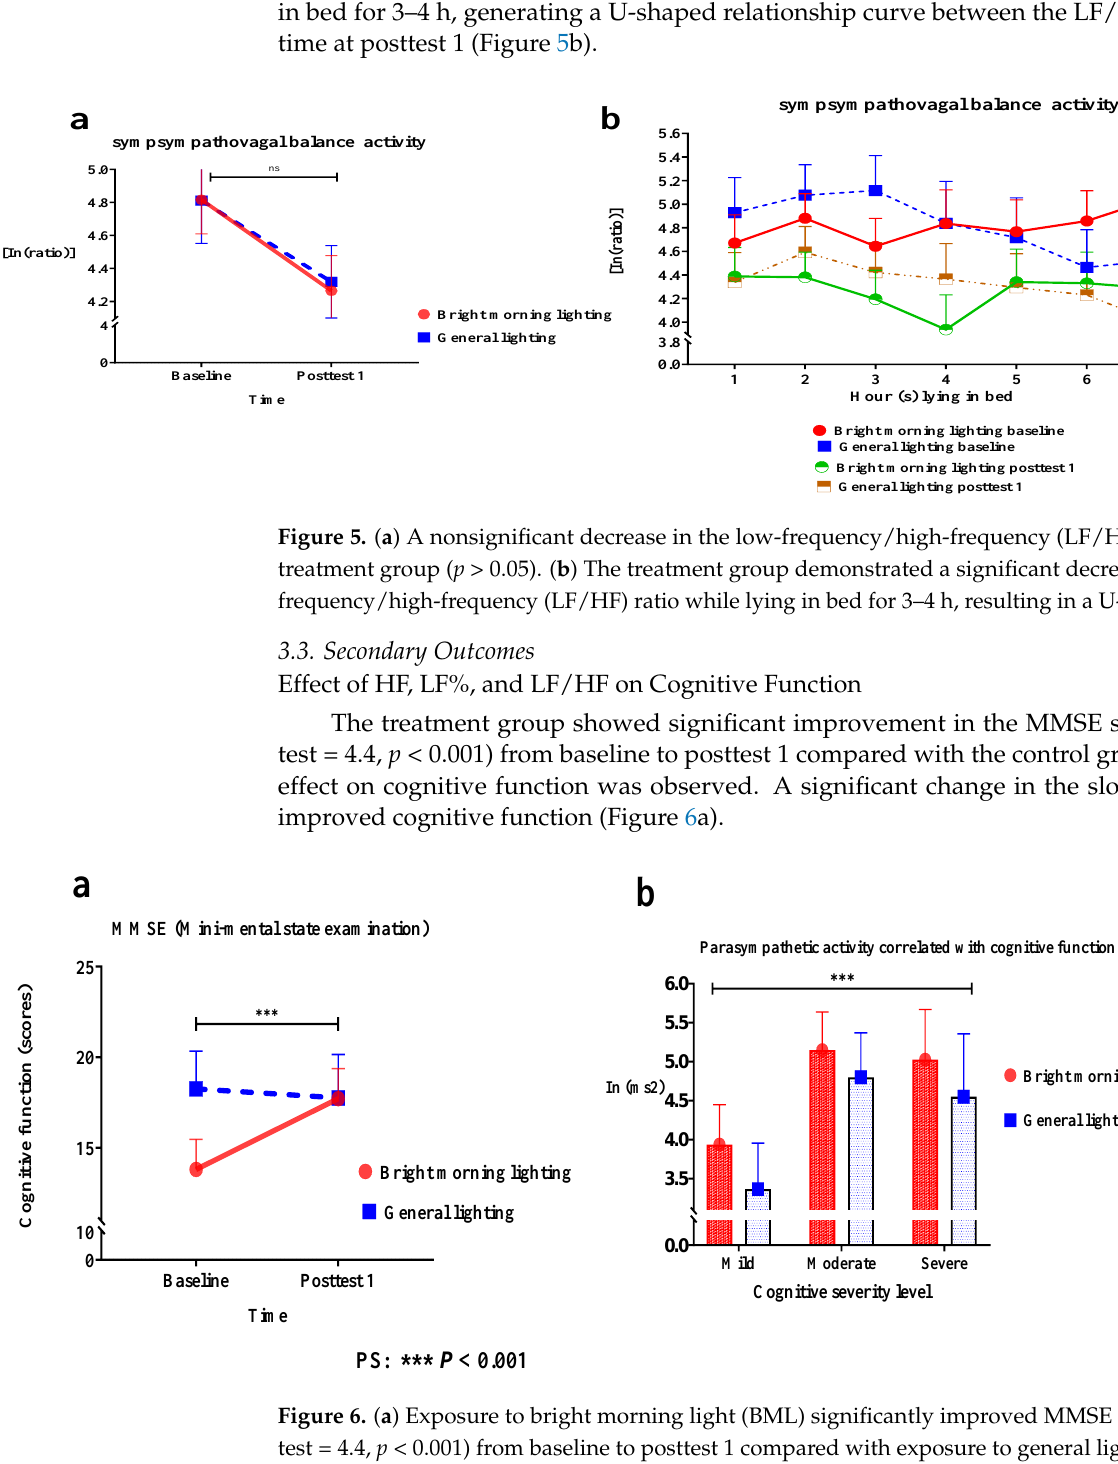
b Figure 4. ( a ) Changes in sympathetic nervous system (SNS) activity in the treatment and control groups while lying in bed for 7 h. The treatment group exhibited a nonsignificant decrease ( p > 0.05). ( b ) The BML group exhibited a significant decrease in LF% power while lying in bed for 2 – 3 h. A U-shaped curve was exhibited at posttest 1. 3.2.3. Effects of BML on Sympathovagal Balance